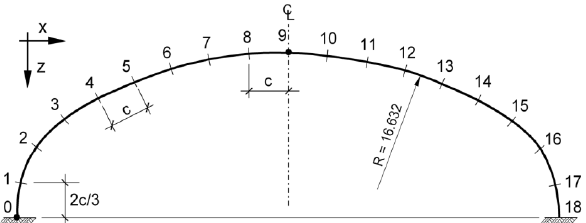
Figure 3: Division into elements in the circumferential